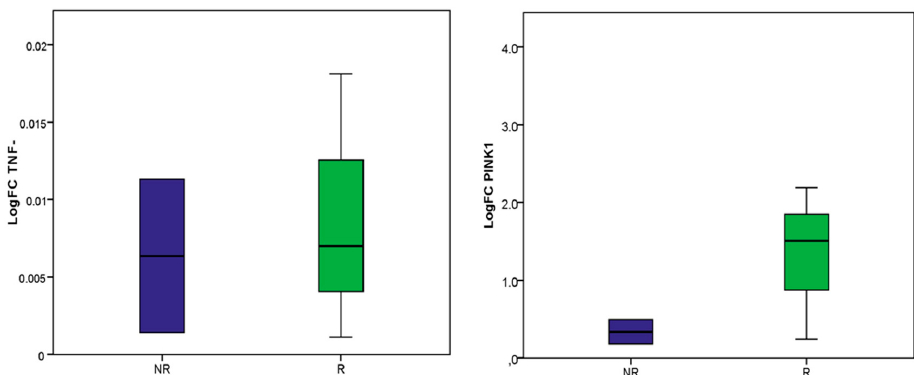
Figure 6. Differential gene expression profiles between radio-induced and non-radio-induced BCC in patients’ blood. Blue box plot: non-radio-induced BCC NR; green box plot: radio-induced BCC R.